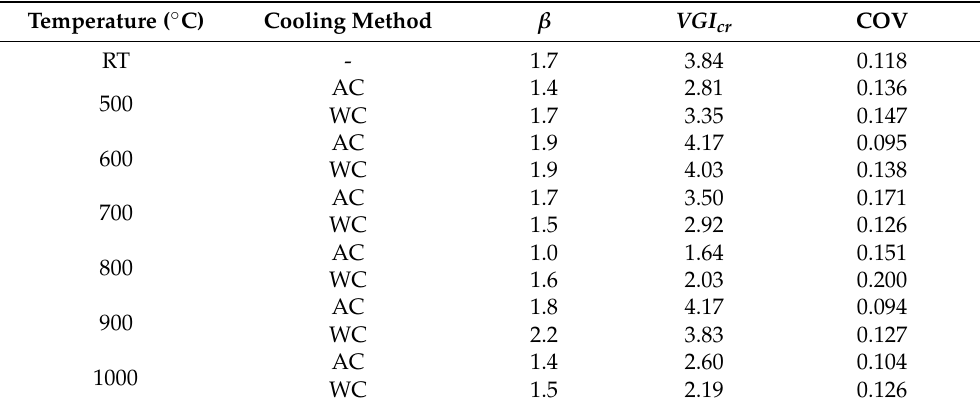
Table 2. VGM parameters for A572 Gr. 50 steels subjected to various temperatures and cooled by different methods.